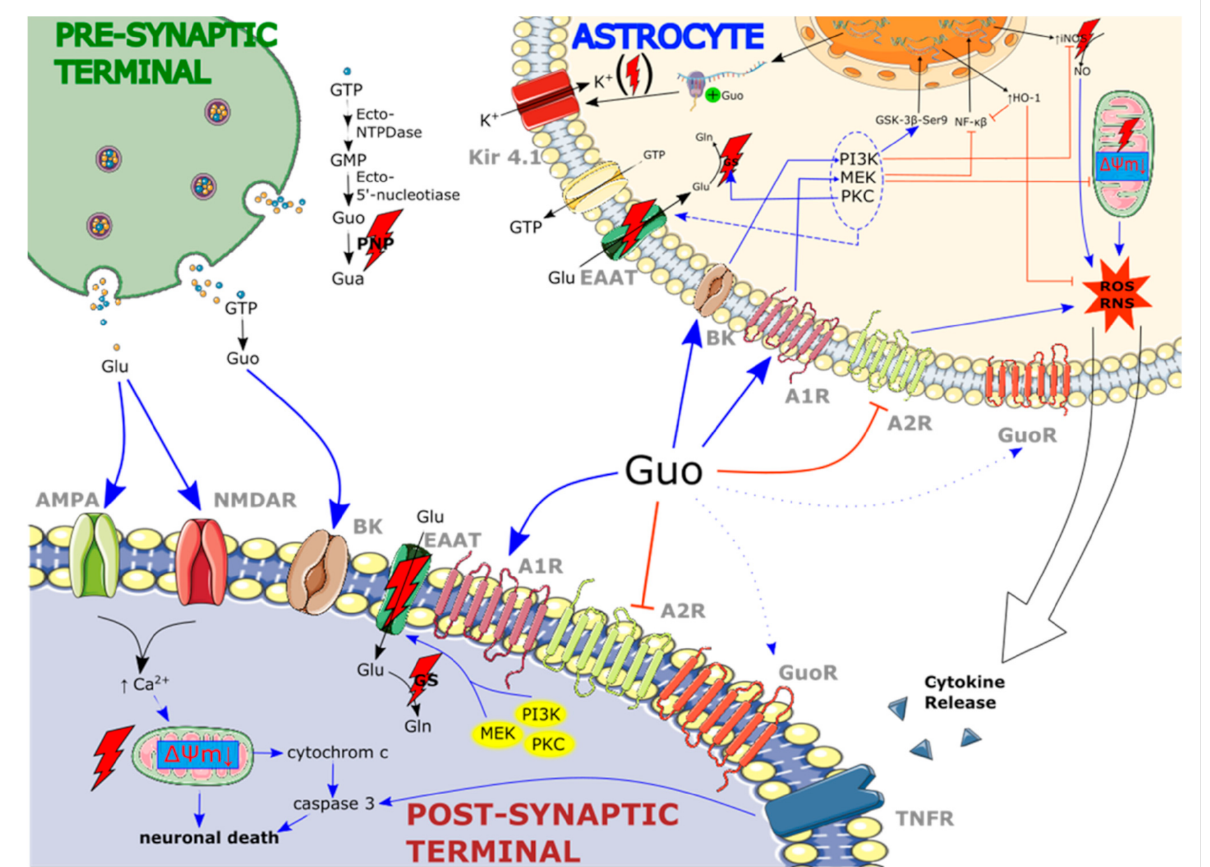
Figure 1. Overview of the most important mechanisms that contribute to guanosine-induced neuroprotection under ischemia: guanosine 5 (cid:48) -triphosphate (GTP) is released from the presynaptic terminal of neurons via synaptic vesicles but can also be transported directly from astrocytes into extracellular space. Extracellular guanosine nucleotides undergo hydrolysis by ectonucleotidases into guanosine 5 (cid:48) -monophosphate (GMP) and subsequently guanosine (Guo). The end product of guanosine nucleotide degradation is guanine. The cleavage of guanosine to guanine (Gua) is catalyzed by purine nucleoside phosphorylase (PNP), the concentration of which is decreased under hypoxic conditions (as marked by a red lightning bolt). Guanosine has a putative specific binding site (GuoR); however, its role has not been fully characterized (the putative Guo–GuoR interaction is marked as dotted arrows). Nevertheless, guanosine can act upon adenosine receptors (A 1 R and A 2A R) and potassium big conductance channels (BK). Guanosine activates cellular molecular pathways, such as PI3K/Akt (PI3K), MEK/ERK (MEK), and protein kinase C (PKC). Activation of these molecular pathways leads to stimulation of amino acid transporters (EAATs) (depicted as a dashed arrow). Moreover, guanosine acting via the PKC pathway increases glutamine synthase (GS) activity which, combined with EAAT stimulation, protects against glutamate excitotoxicity. The physiological base activity of EAATs and GS is disturbed under ischemic conditions. Guanosine promotes protection against reactive oxygen species (ROS) and reactive nitrogen species (RNS) by activation of MEK and PI3K. These cellular pathways downregulate the expression of iNOS via NF-kb inhibition, upregulate expression of HO-1 via GSK-3 β phosphorylation at Ser9 (GSK-3 β -Ser9), and prevent loss of mitochondrial membrane potential ( ∆Ψ m ↓ ). Notice that some of these effects counteract the detrimental events that occur under ischemic conditions. These include mitochondrial membrane depolarization and iNOS upregulation. The consequence of increased ROS/RNS production is a release of proinflammatory cytokines (marked as an open arrow) some of which then act on tumor necrosis factor receptors (TNFR) promoting apoptosis in neurons. Chronic supplementation of guanosine prevents reduction of inwardly rectifying K + channels (Kir 4.1) by promoting de novo Kir4. 1 synthesis. Importantly, expression of Kir 4.1 and/or Kir-mediated currents are reduced up to 14 days after an ischemic injury (marked as red lightning bolt put in braces). Figure designed using image template from Servier Medical Art https://smart.servier.com/image-set-download/, accessed on 12 March 2021. Guo induces the phosphorylation of protein kinase B (PKB/Akt) via PI3K, which leads to the inactivation of GSK3 β through phosphorylation at Ser9 [100]. In a study by